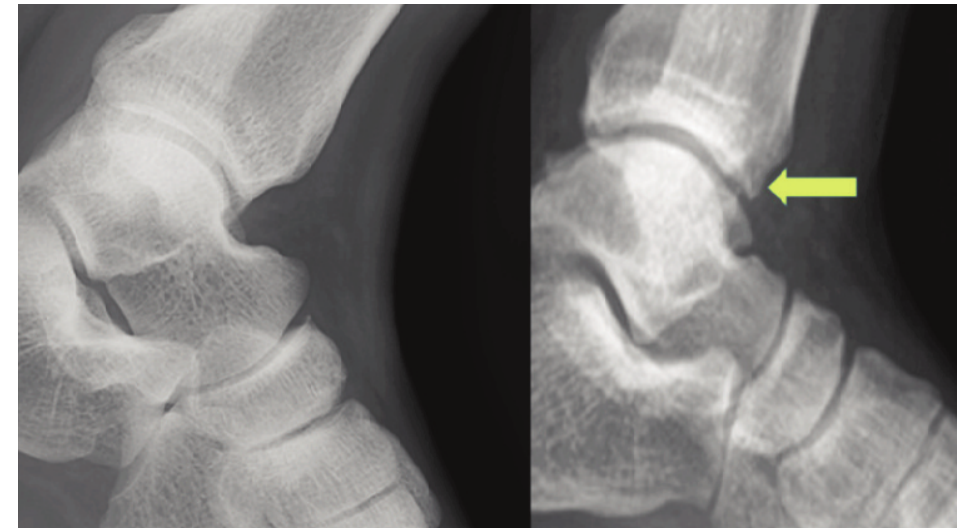
Showing degenerative changes in ankle joint at latest follow-up. Arrow showing anterior and posterior lipping along with Fig. 4: sclerosis of subchondral bone (grade 1 OA changes).